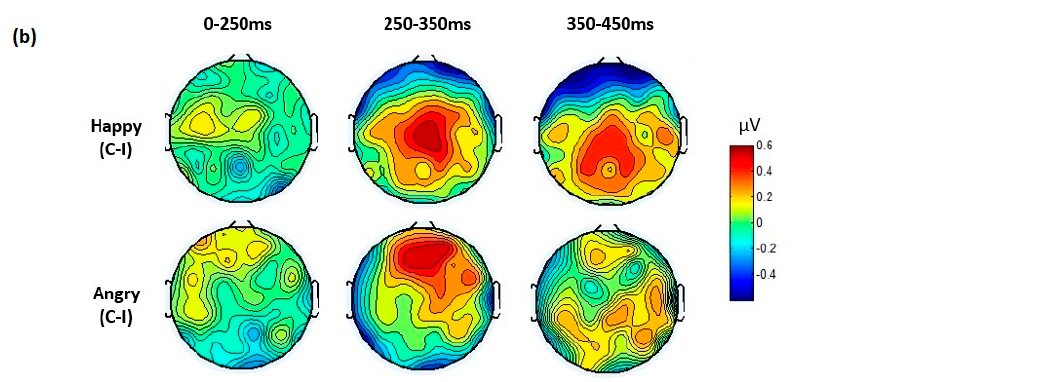
Figure 7. The effect of congruency varied with the face emotion. ( a ) : group grand averaged waveforms for each face emotion and congruency condition (averaged across tasks) displayed at Fz and CPz sites. ( b ): topographic maps representing the congruency effect (congruent minus incongruent conditions) are displayed for each face emotion between face onset (0 ms) and 450 ms. The congruency effect displayed a clear centro-parietal distribution for happy face expressions and a clear frontal distribution for angry face expressions, restricted to 250–350 ms.